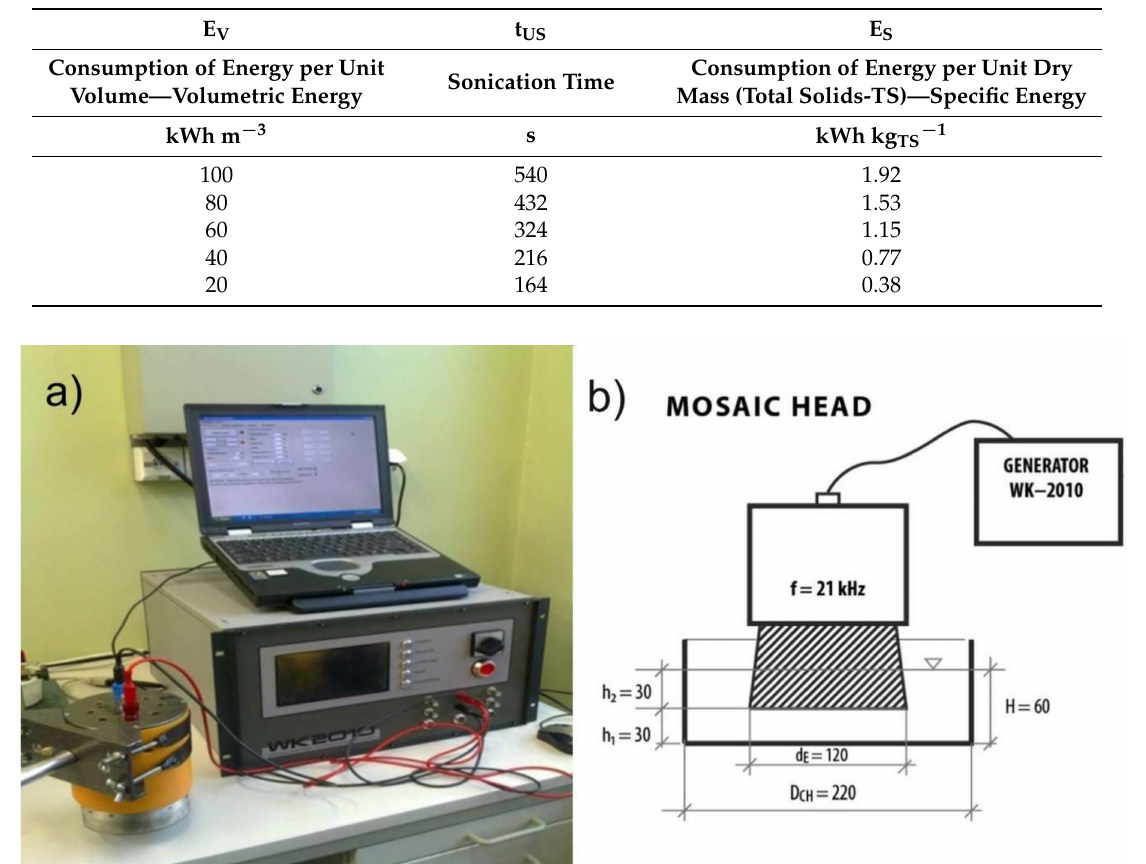
Table 4. Parameters of the ultrasonic disintegration.